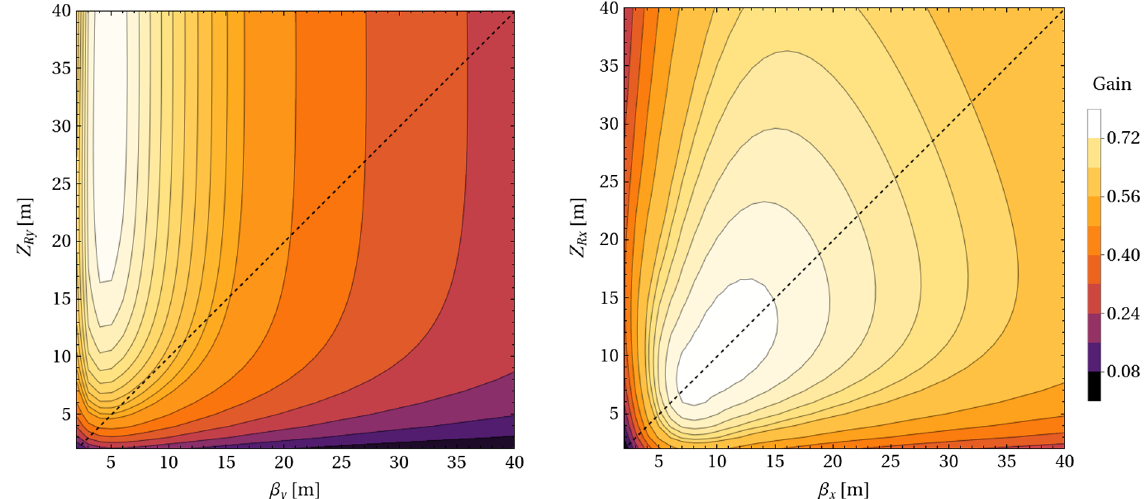
6. Contour plot of gain vs electron and photon beam parameters in x (right) and y (left). In the x direction, peak gain is located Z along the β line (black, dashed) as predicted by traditional FEL theory. In the y direction, the contours are much more x ¼ Rx asymmetric due to the dispersion introduced by the TGU. In both directions, there are generous margins for potentially tuning these beam parameters while still maintaining respectable